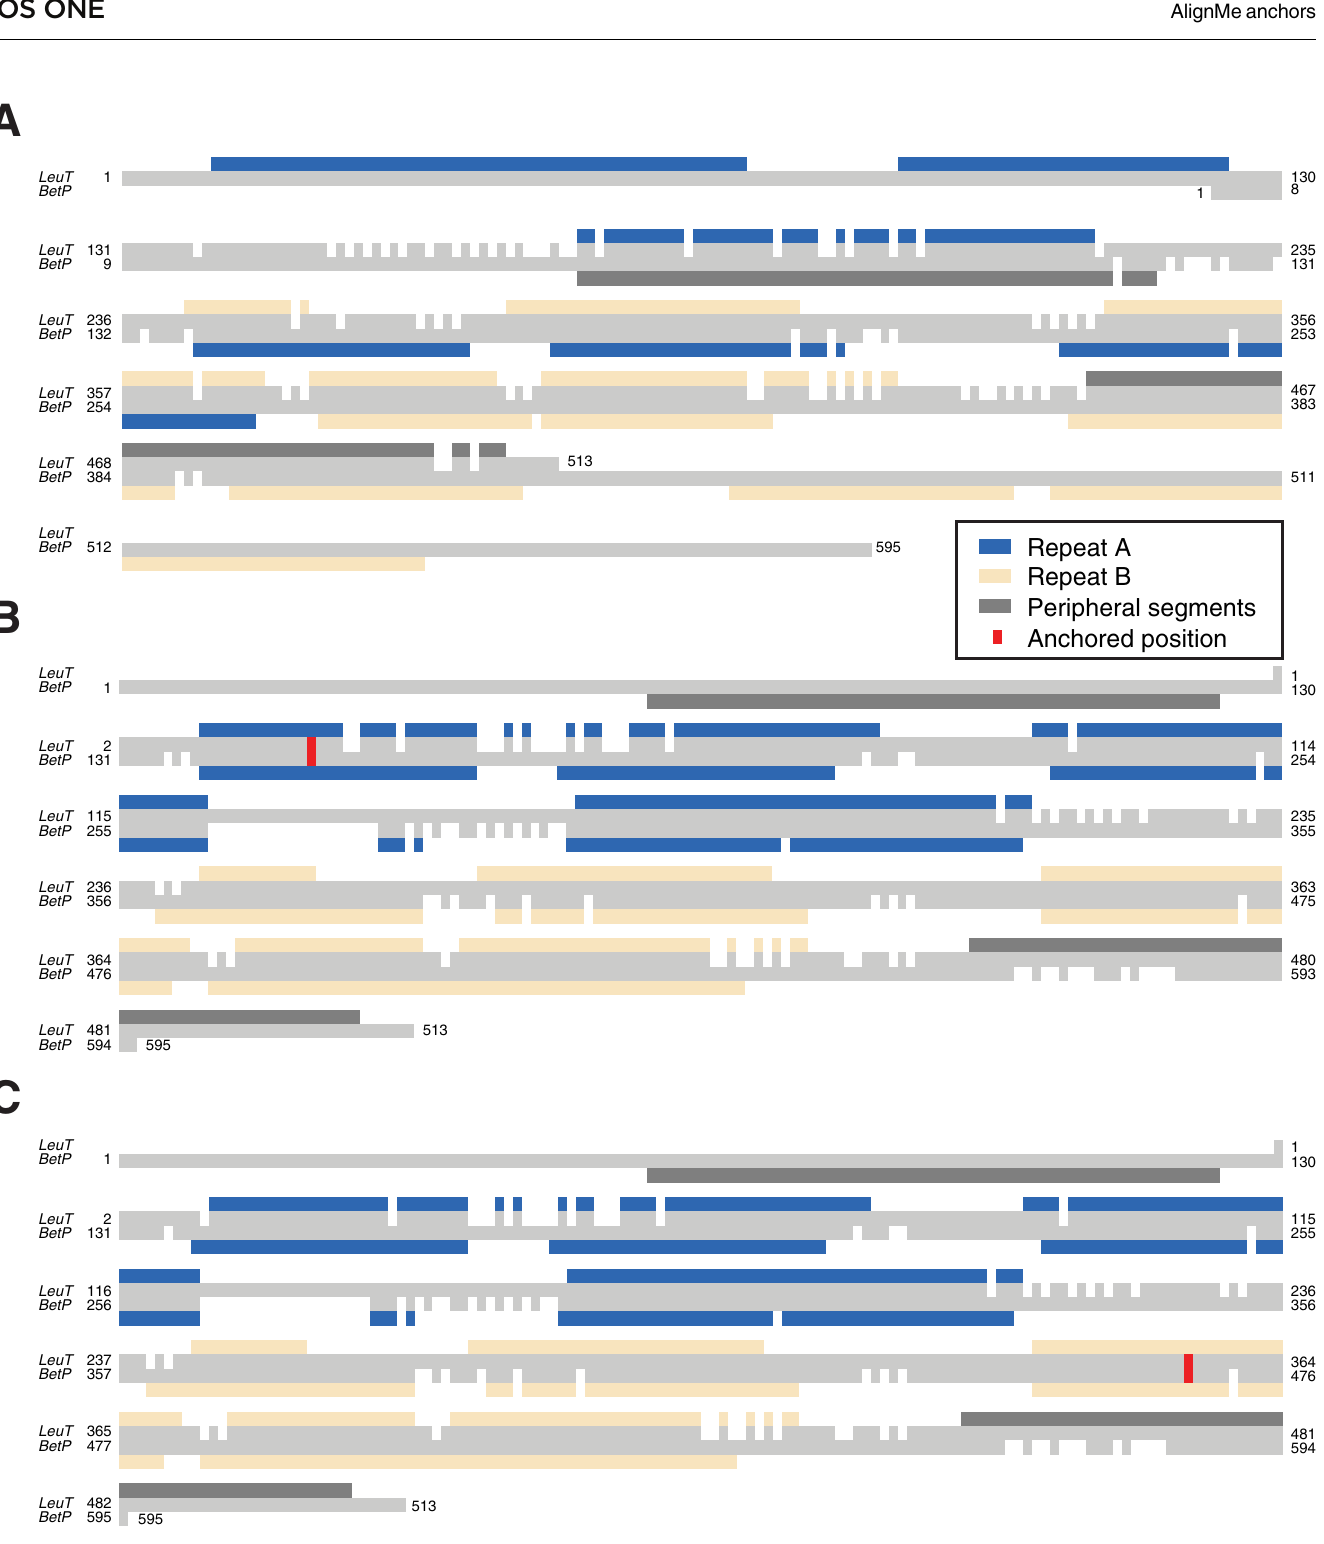
PLOS ONE | https://doi.org/10.1371/journal.pone.0239881 April 30,